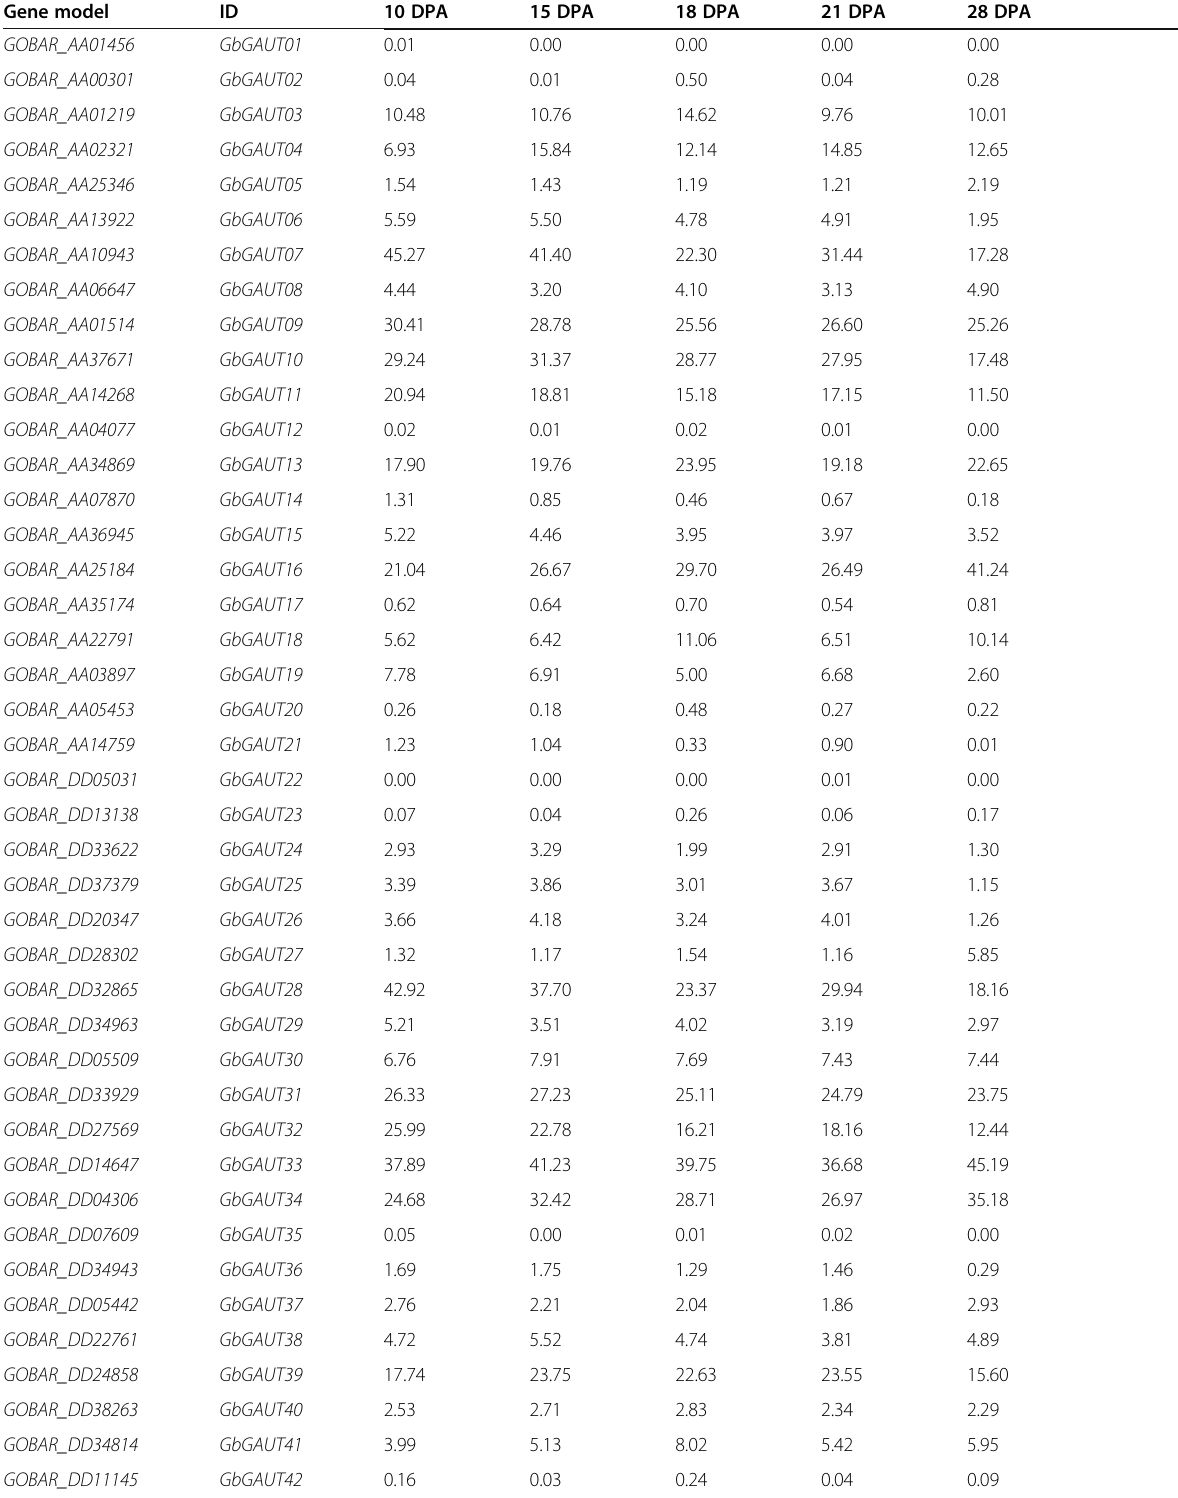
Table 4 The FPKM value of GAUT genes in G. barbadense Gene